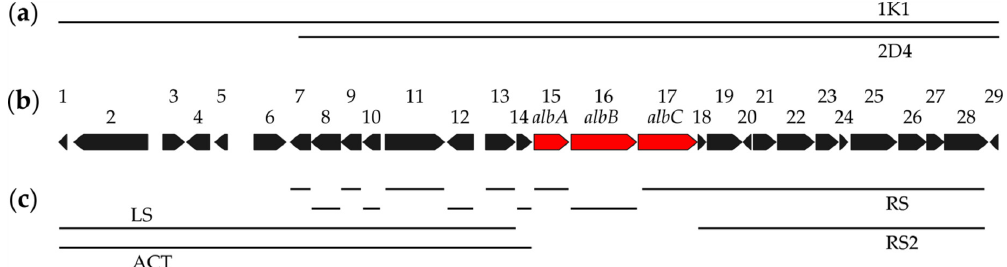
Figure 1. Chromosomal fragment of S. albus subsp. chlorinus NRRL B-24108 with the albucidin biosynthetic genes. ( a ) Schematic representations of DNA fragments cloned in BACs 1K1 and 2D4;